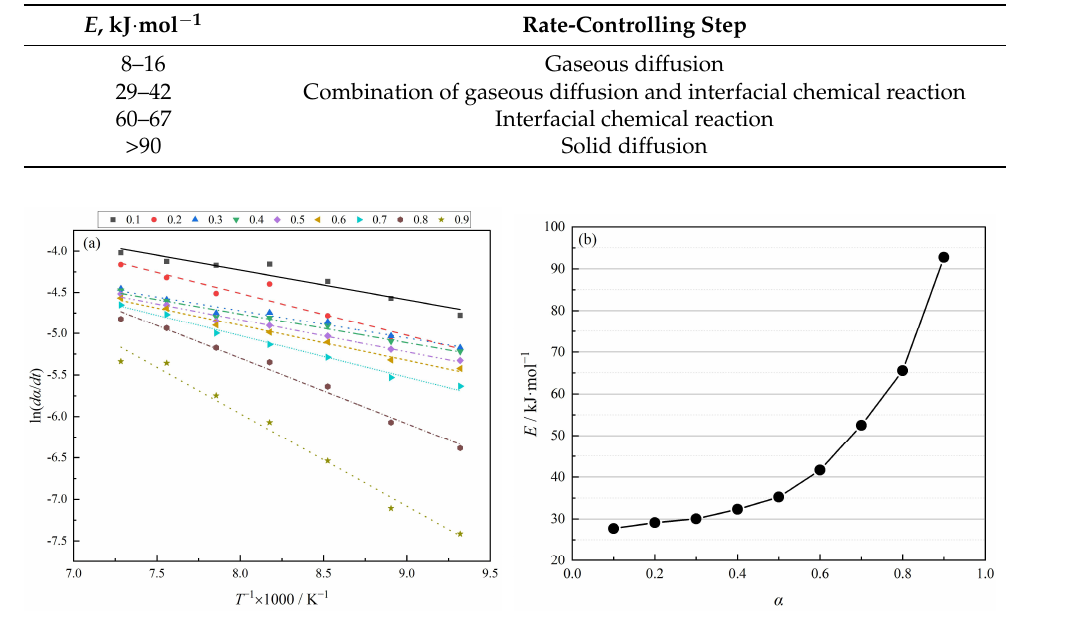
Table 5. Avrami–Erofeev exponent n at 800–1100 °C for samples.